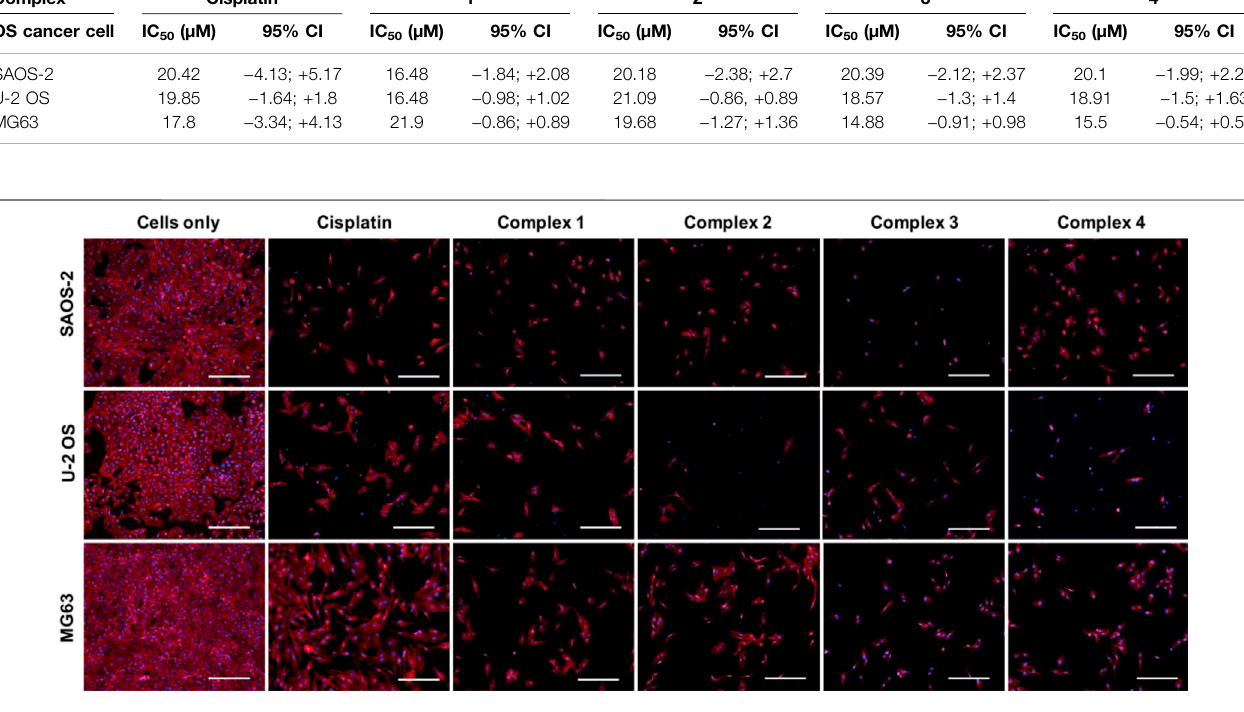
Frontiers in Chemistry |